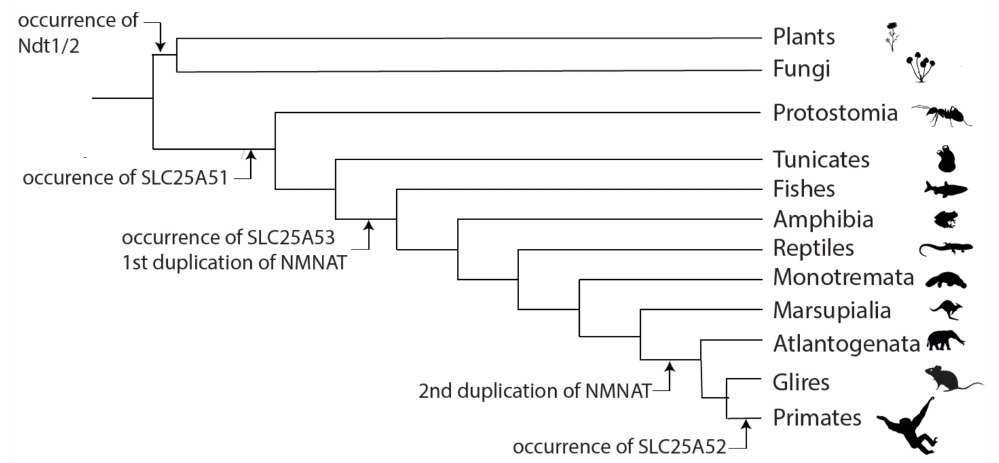
Figure 5. Evolutionary events related to compartmentation of NAD + biosynthesis. The scheme illustrates major evolutionary events related to mitochondrial NAD + metabolism. Ndt1/2 can only be found in plants and fungi, whereas SLC25A51 homologues can be detected in all Metazoan starting from Protostomia. The functionally uncharacterized paralogue SLC25A53 is first found in vertebrates, whereas SLC25A52 can only be found in primates. In parallel, the different isoforms of NMNATs developed. The first duplication of NMNATs in the last common ancestor of vertebrates gave rise to NMNAT2, whereas the later gene duplication in mammals lead to the development of the mitochondrial isoform NMNAT3 [75]. The tree is a schematic representation of selected taxa and is based on information from Tree of Life Web Project